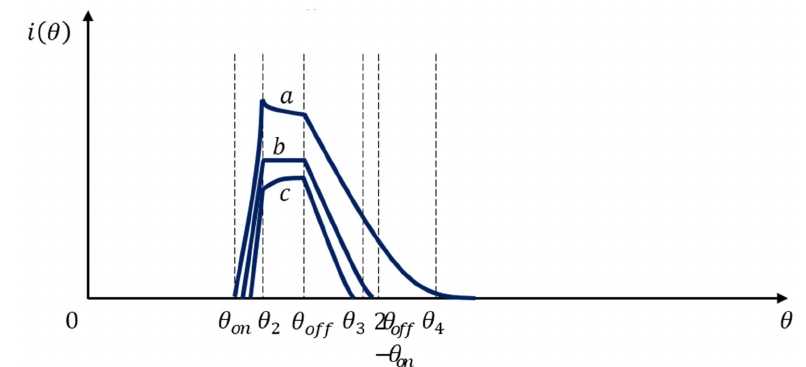
Figure 4. Current curves with constant turn-off angles and different turn-on angles. When the turn-on angle θ on < θ 2 − L / [( L max − L min ) / β r ] and di / d θ < 0, the current drops in the inductance rising region, as shown by curve a in Figure 4. This is because when the turn-on angle is too small, the current rises too fast, and when the motor turns to θ 2, the current amplitude is too large, making the torque too large. At this time, the amplitude of the back EMF is greater than the bus voltage, and so the current decreases.